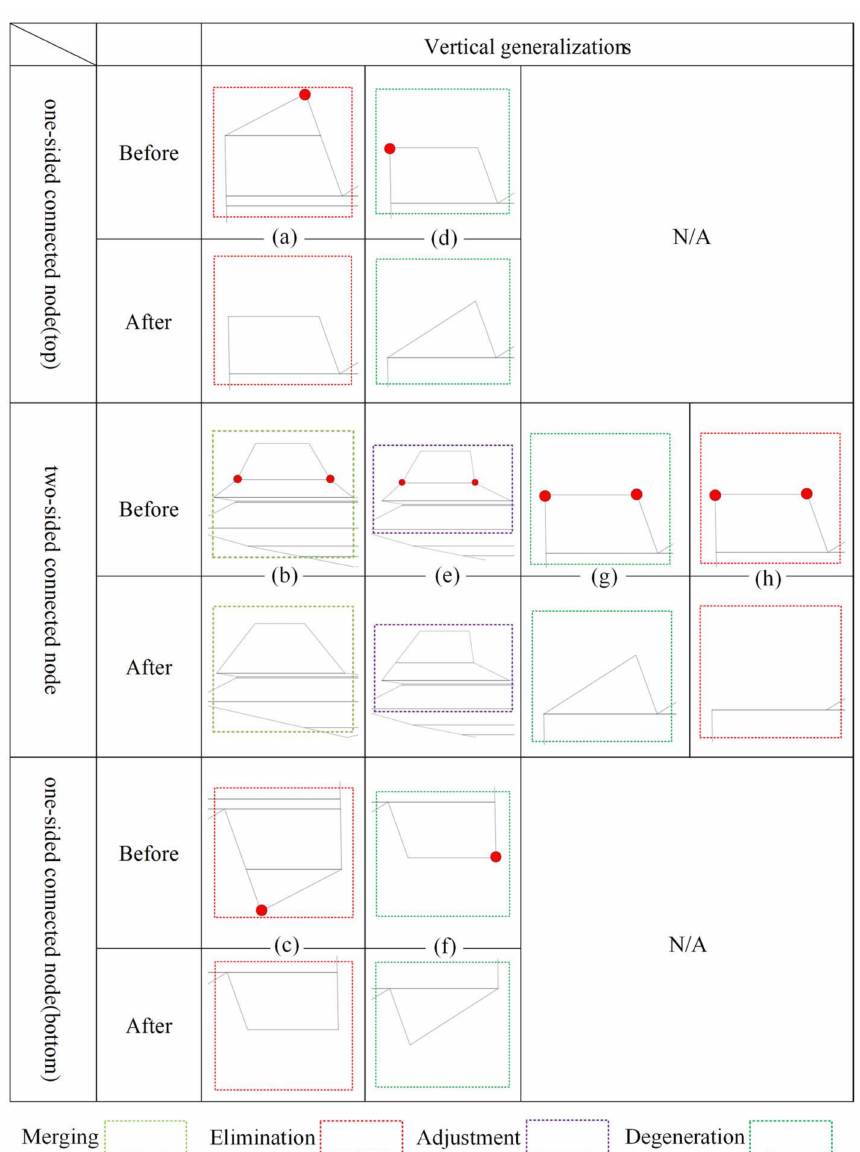
Figure 4. Vertical trapezoidal generalizations, comprising four trapezoidal operators: merging, degeneration, elimination and adjustment. ( a ) trapezoid elimination, ( b ) trapezoid merging, ( c ) is the same with ( a ), but the vertex is at the bottom, ( d ) trapezoid degeneration, ( f ) is the same with ( d ), but the vertex is at the bottom, ( g ) trapezoid degeneration, in which the vertex is a two-weight side and the other vertex needs to be kept, ( h ) trapezoid elimination, in which the vertex is a two-weight side and both need to be deleted, the trapezoid will be